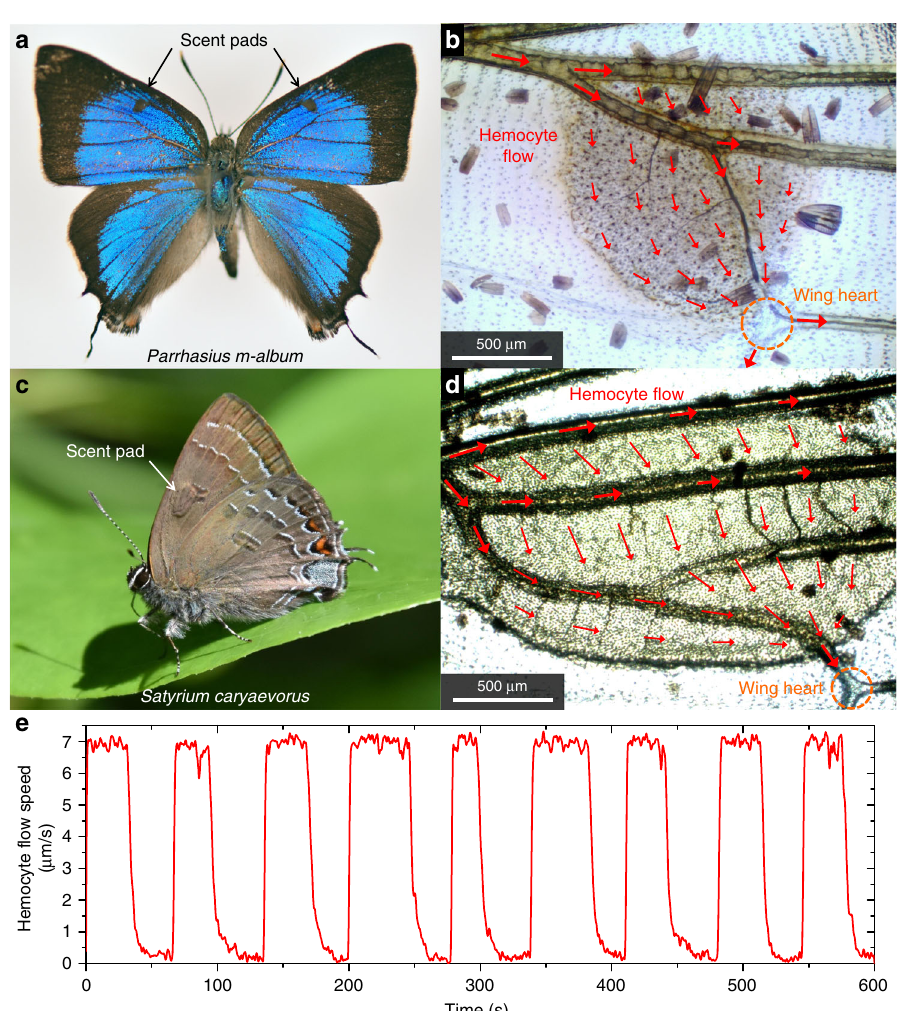
Fig. 2 Hemolymph fl ow in scent pads. a Photo of a male white-M hairstreak, Parrhasius m-album . b Photo showing the scent pad of P. m-album , an associated “ wing heart ” , and the observed pattern of hemocyte fl ow in the scent pad. c Photo of a male hickory hairstreak, Satyrium caryaevorus . d Photo showing the scent pad of S. caryaevorus , an associated “ wing heart ” , and observed pattern of hemocyte fl ow in the scent pad. e Observed average hemocyte fl ow speed as a function of time in the scent pad of S. caryaevorus . Supplementary Movies 4, 5 show the beating of the wing heart and movement of hemocytes within the scent pad of P. m-album . Supplementary Movies 6, 7 show the movement of hemocytes within the scent pad of S. caryaevorus . Source data are provided as a Source Data fi fused, thereby forming intermembrane pockets; scent patches are found in many other groups of butter fl ies as well as in the Eumaeini, and occur in regions of the wing where the dorsal and ventral membranes are fused. Both scent pads and patches are covered by modi fi ed scales that are distinct from scales on other parts of the wing. They can exist alone or together on a wing. When found together, they are almost always adjacent to each other. discal cell (Fig. 2b, d, e and Supplementary Movies 4 – 7). This is